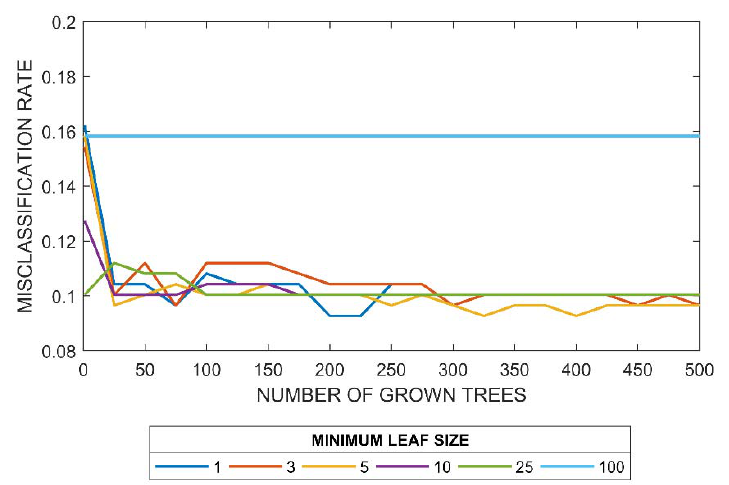
Figure 9. Sensitivity of model performance described by the misclassification rate of the testing set to ensemble size and maximum tree depth.